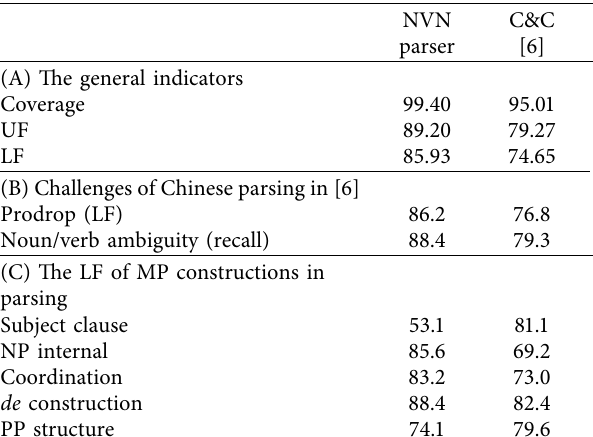
Table 11: Evaluation for NVN parser and